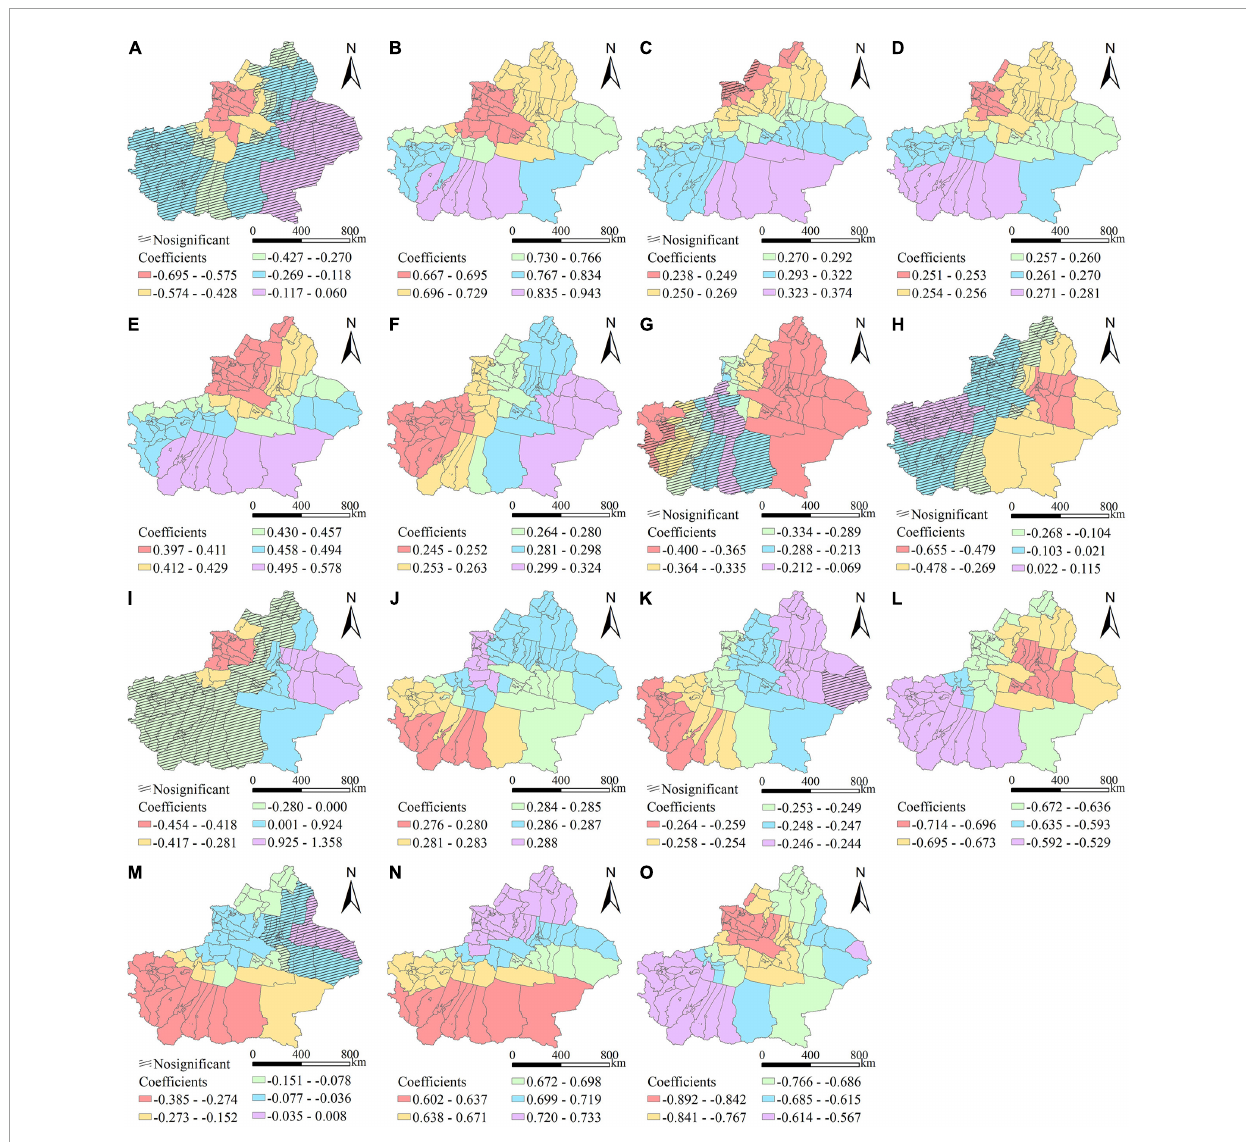
FIGURE6 Expression of spatial heterogeneity of drivers. (A–D) CS–SL, CS–FVC, CS–PRE, and CS–PU. (E–G) HQ–FVC, HQ–PRE, and HQ–PU. (H–K) SF–FVC, SF–PRE, SF–PD, and SF–PU. (L–O) WY–DEM, WY–FVC, WY–PRE, and WY–TEM. (CS, carbon storage; HQ, habitat quality; SF, sand fixation; WY, water yield; DEM, digital elevation model; SL, slope; FVC, fractional vegetation cover; PRE, precipitation; TEM, temperature; PU, percentage of urban area; PD, population density).